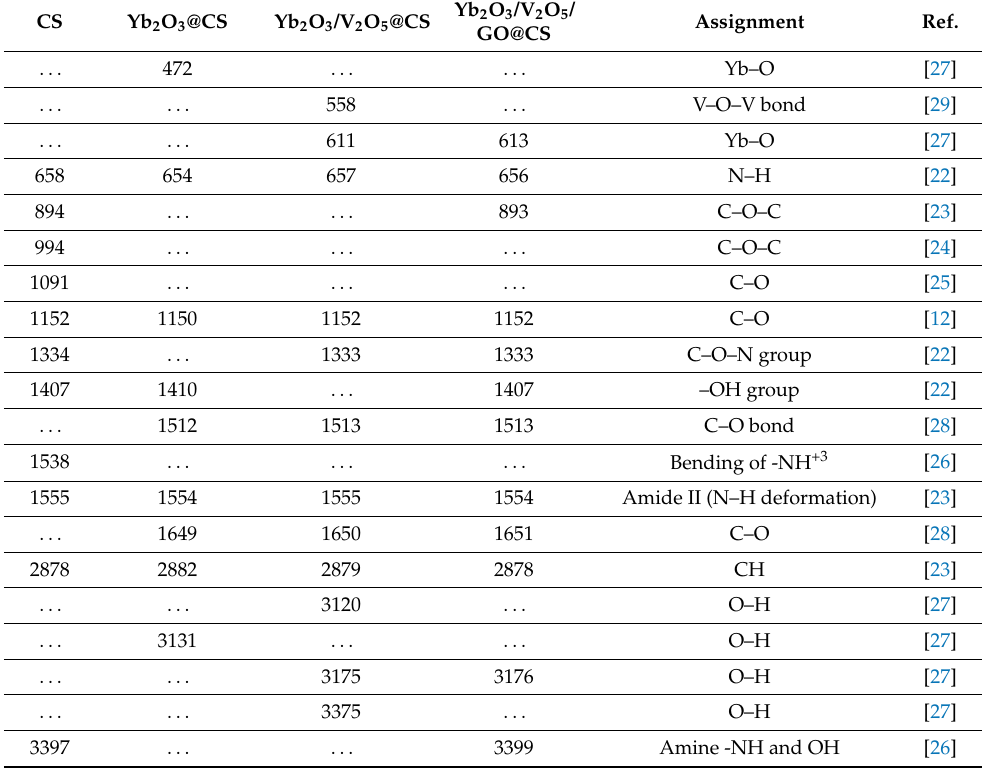
Figure 2. FTIR of CS films with a different contribution of nanoparticles. Table 1. FTIR spectra of CS films with nanocomposites in different concentrations.